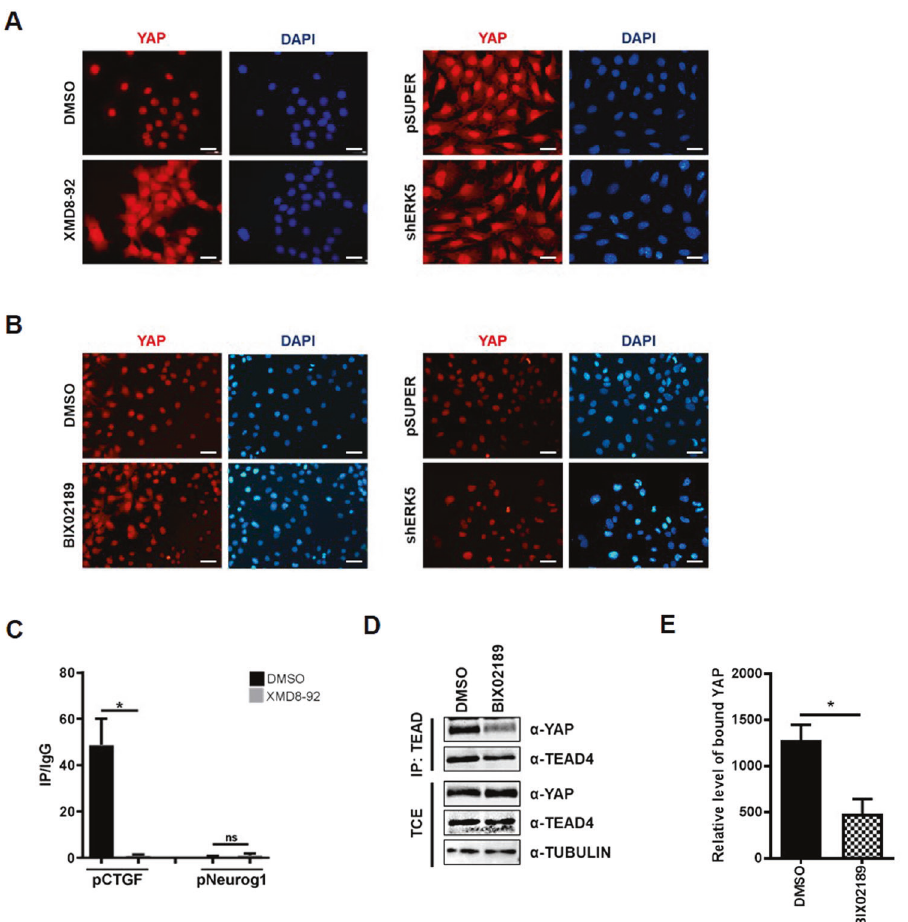
Fig. 5 ERK5 activity is required for the recruitment of YAP on target gene promoters and for YAP/TEAD interaction. A Immuno fl uorescence analysis of RLSC treated with XMD8-92 or with DMSO for 16 h (left panels) and of RLSC transfected with shERK5 or with the empty vector (right panels). Cells were stained with an anti-YAP antibody (red) and DAPI (nuclei, blue). Images are representative of three independent experiments. Scale bar: 50 µm. B Immuno fl uorescence analysis of HuH7 treated with BIX02189 or with DMSO for 16 h (left panels) and of HuH7 transfected with shERK5 or with the empty vector (right panels). Cells were stained with an anti-YAP antibody (red) and DAPI (nuclei, blue). Images are representative of three independent experiments. Scale bar: 50 µm. C qPCR analysis of ChIP assays with